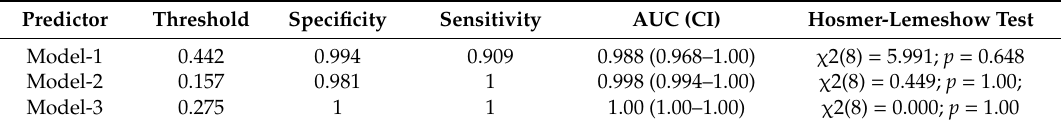
Table 2. Prediction Performance and best thresholds for the